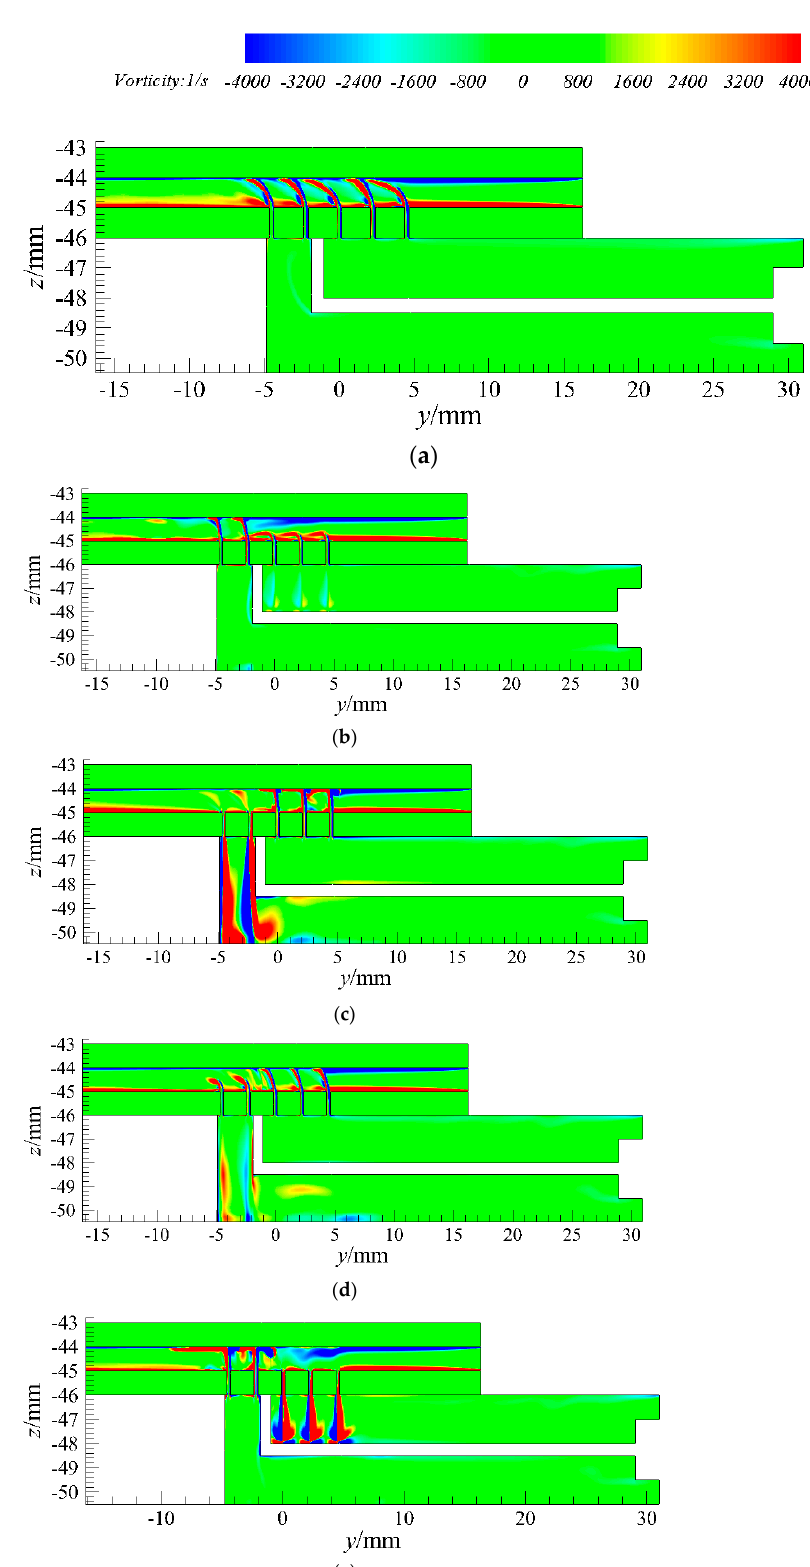
Figure 14. X vorticity distribution of channel’s center section ( x = 28.5 mm, overall view): ( a ) DSJ off; ( b ) 0 T (1 T); ( c ) 0.25 T; ( d ) 0.5 T; ( e ) 0.75 T ( d , e , DSJ on).